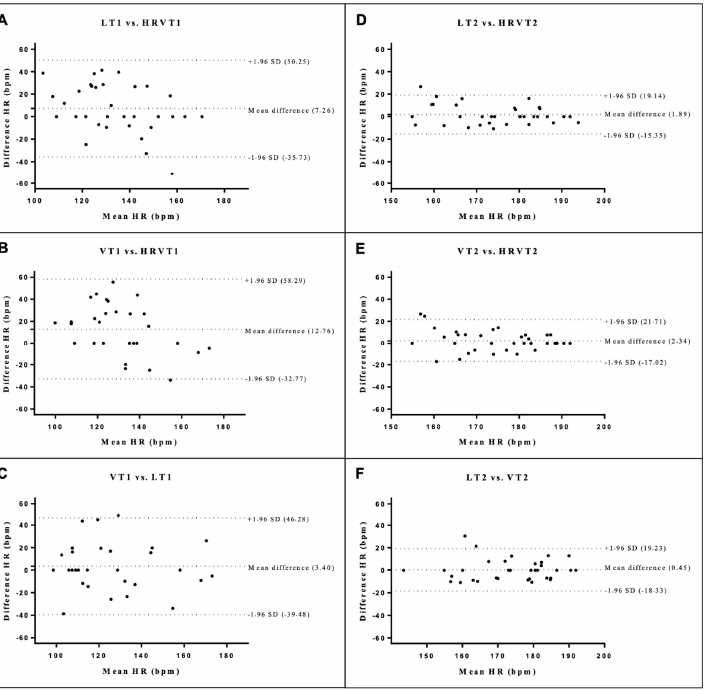
Figure 4. Bland Altman plots for HR at thresholds 1 ( A – C ) and 2 ( D – F ). The dashed lines at the ends represent the limits of agreement (1.96 SD) and the dashed central lines (bias). Lactate threshold 1 (LT1), ventilatory threshold 1 (VT1), heart rate variability threshold 1 (HRVT1), lactate threshold 2 (LT2), ventilatory threshold 2 (VT2), heart rate variability threshold 2 (HRVT2).